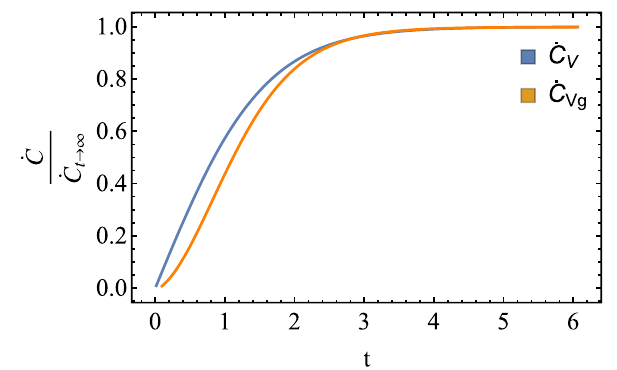
Fig. 4 The CV complexity growth rate for the planar case for both the CV conjecture and the generalized CV conjecture, where we set k = 0 , l ct = 1 , L = 1 and m = 0 .